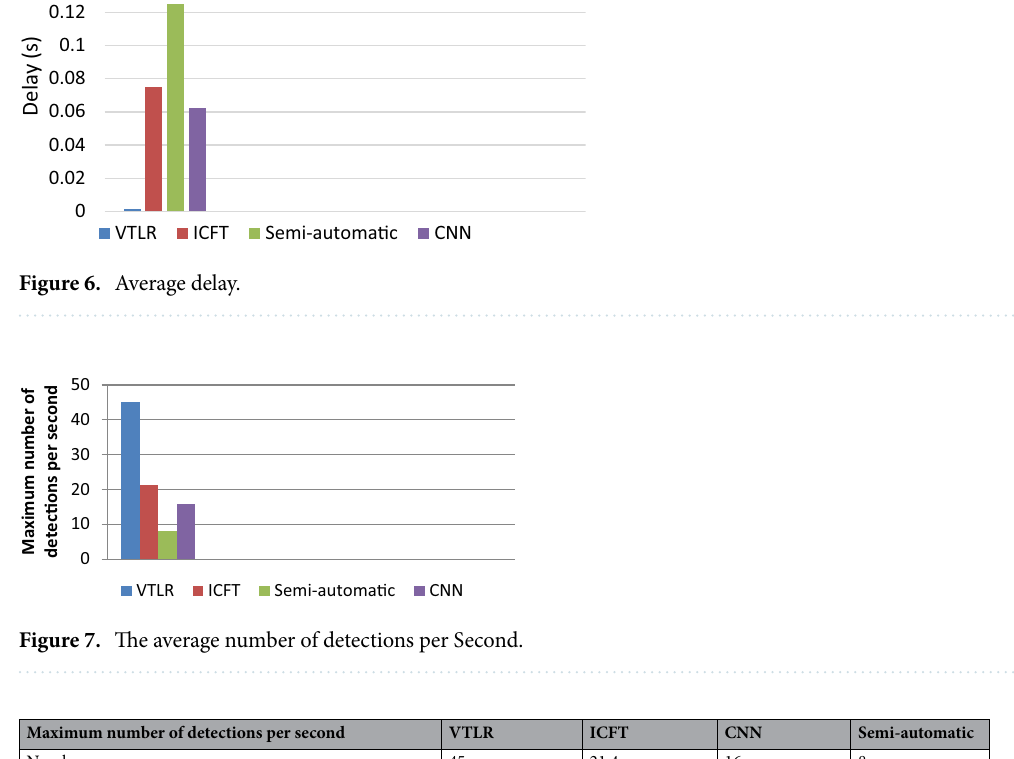
Maximum number of detections per